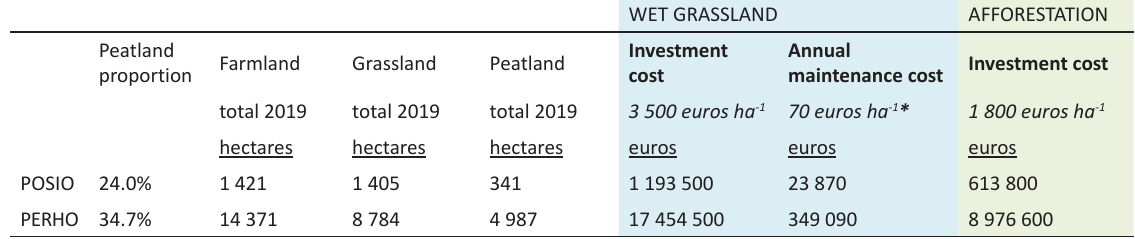
Table 3. Different levels of investment costs and subsidy payments calculated for Posio (Northern Finland) and Perho (Ostrobothnia)